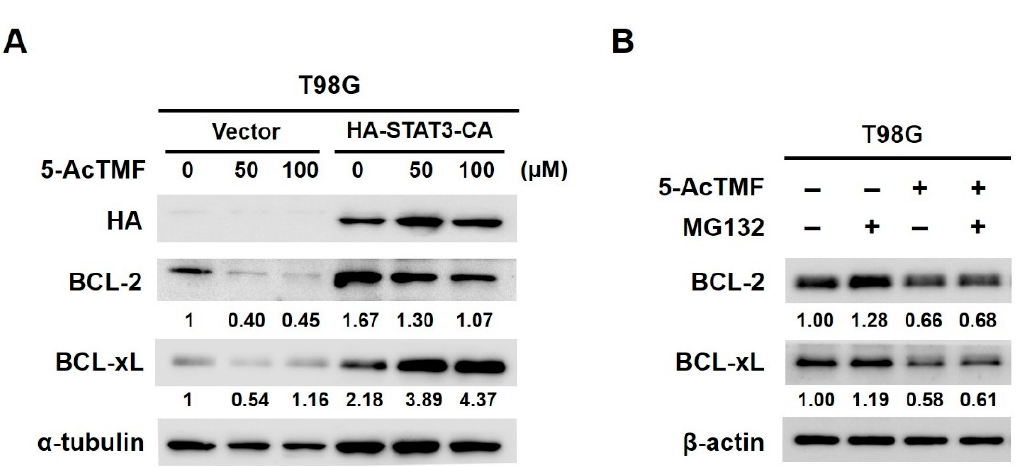
Figure 4. 5-AcTMF downregulates antiapoptotic BCL-2 and BCL-xL through suppression of